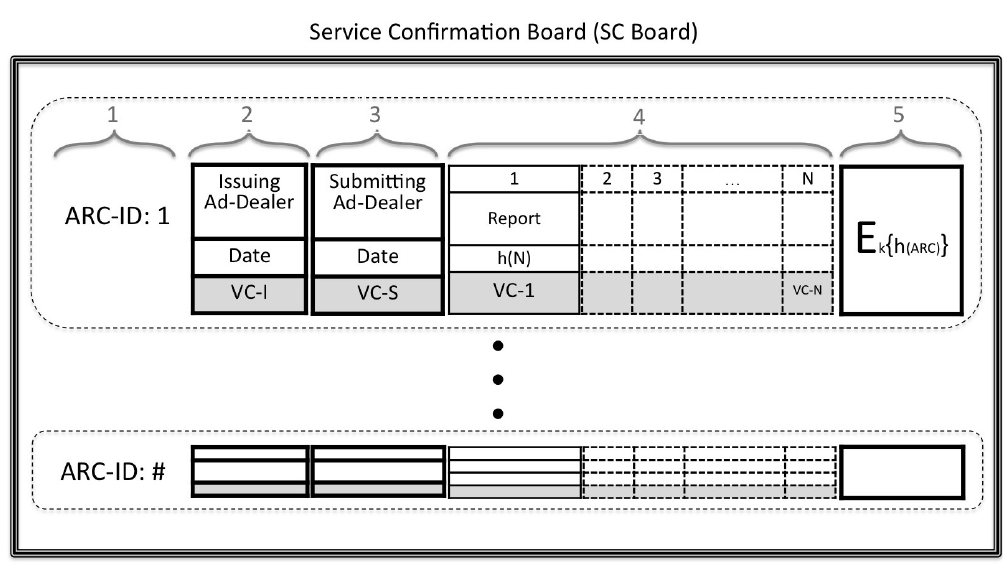
Figure 5. Service Confirmation Board